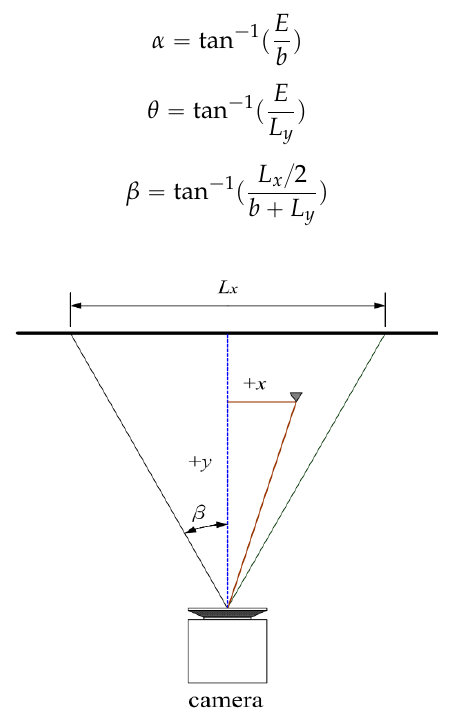
Figure 2. Top view of camera [17].